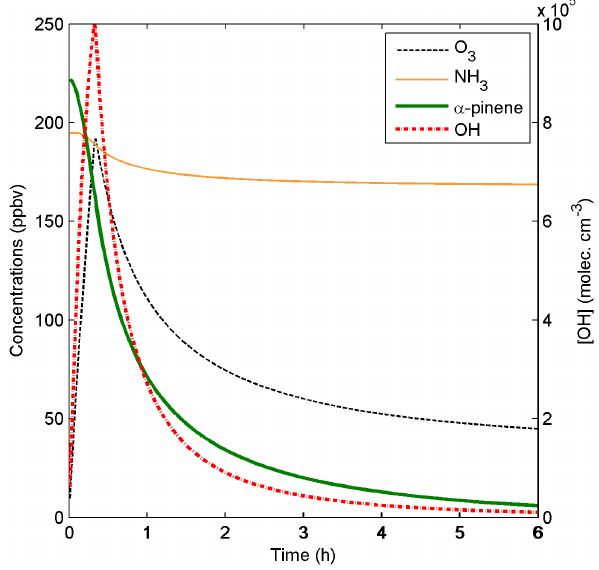
Figure 8. Modelled NH 3 (g), O 3 (g), α -pinene(g) and OH(g) concen- trations for the α -pinene oxidation experiments by Na et al.